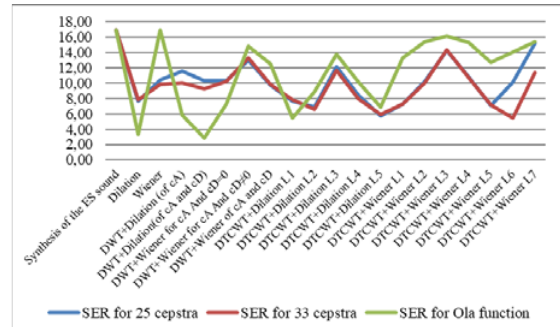
Fig. 6. Variation curves of the SER of hybrid method 1 (25/33 cepstra) and hybrid method 2 (Ola function) according to the operations performed in experiment 1.